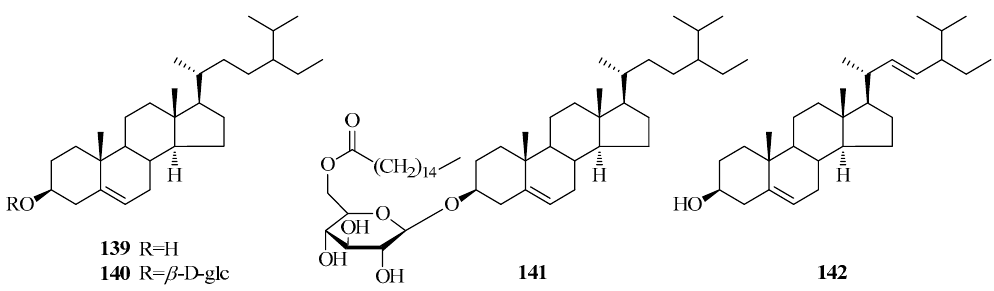
Figure 4. Phytosterol-type steroids from the genus Periploca .